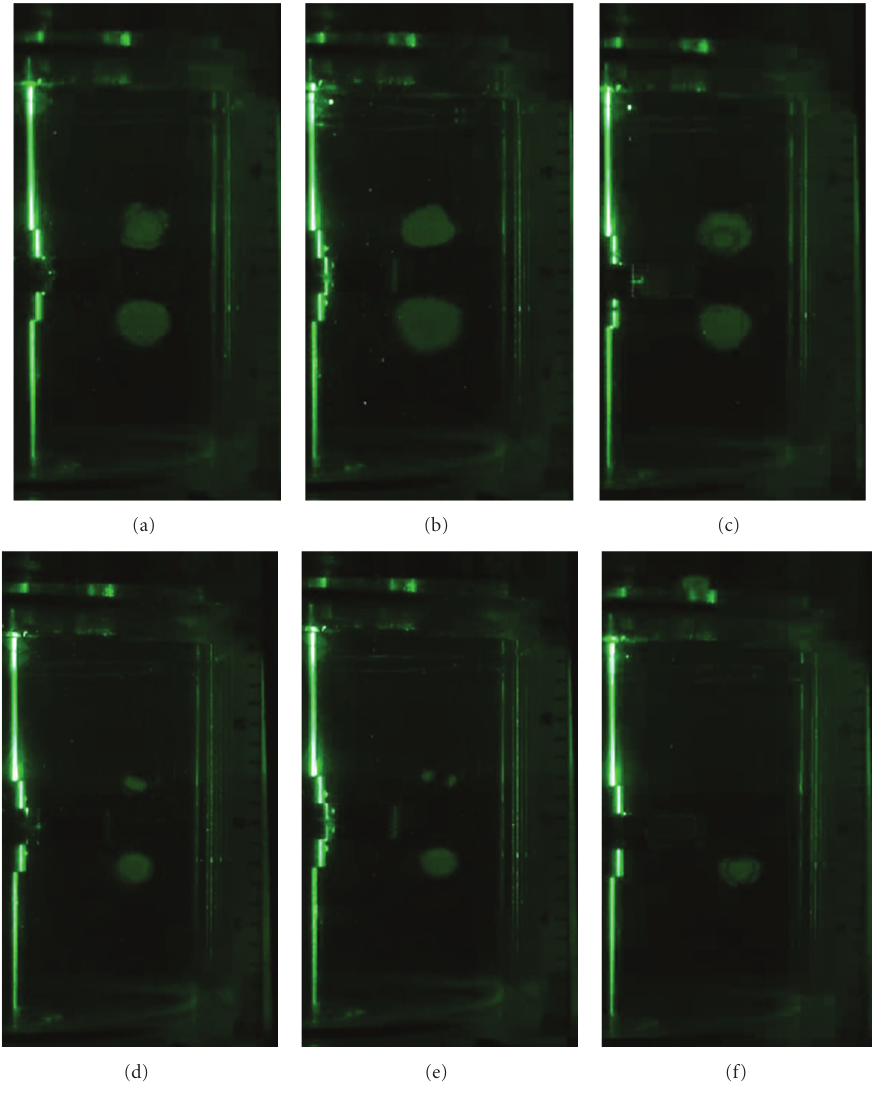
Figure 4: Cross-sectional views of IMR transition, Δ T = 10